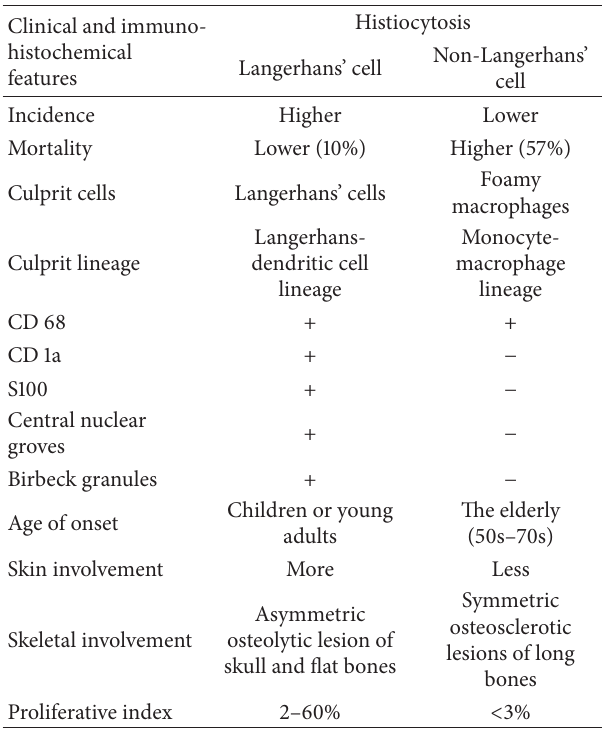
Table 1: Pertinent differences between the two varieties of histio- cytic